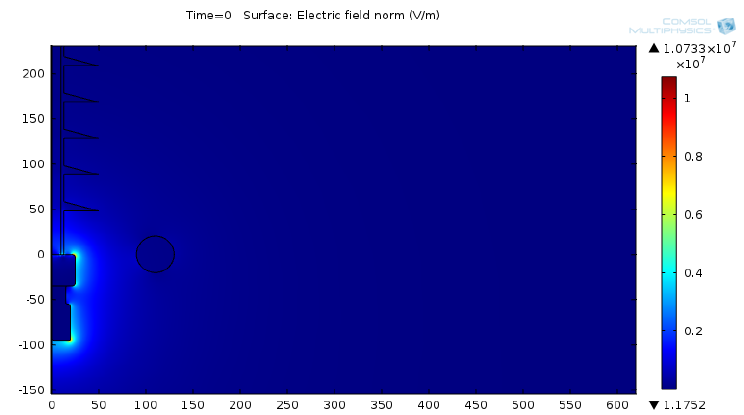
Figure 7. Electric field distribution of an insulator after the simulation.